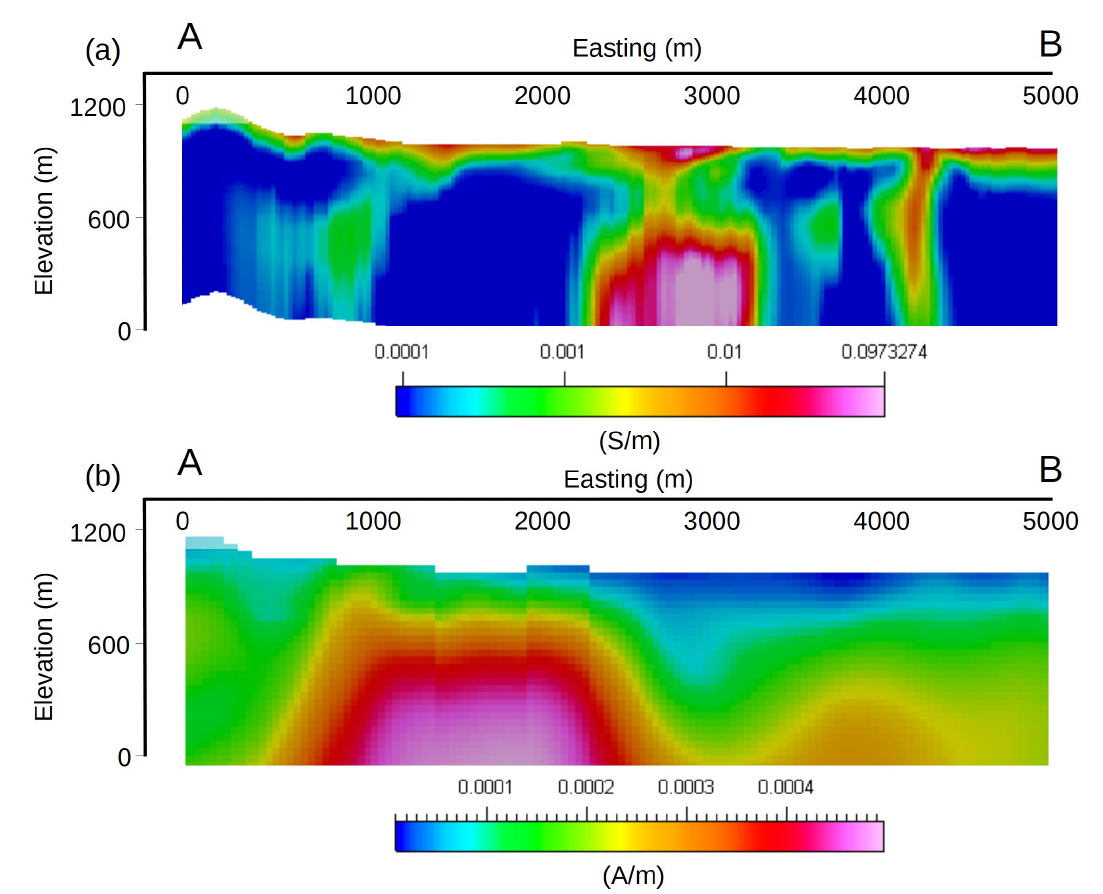
Figure 13. Combined conductivity and magnetic images of the same anomaly shown in Figure 12 along line A to B. Panel ( a ) shows the conductivity, while panel ( b ) shows the magnetic vector